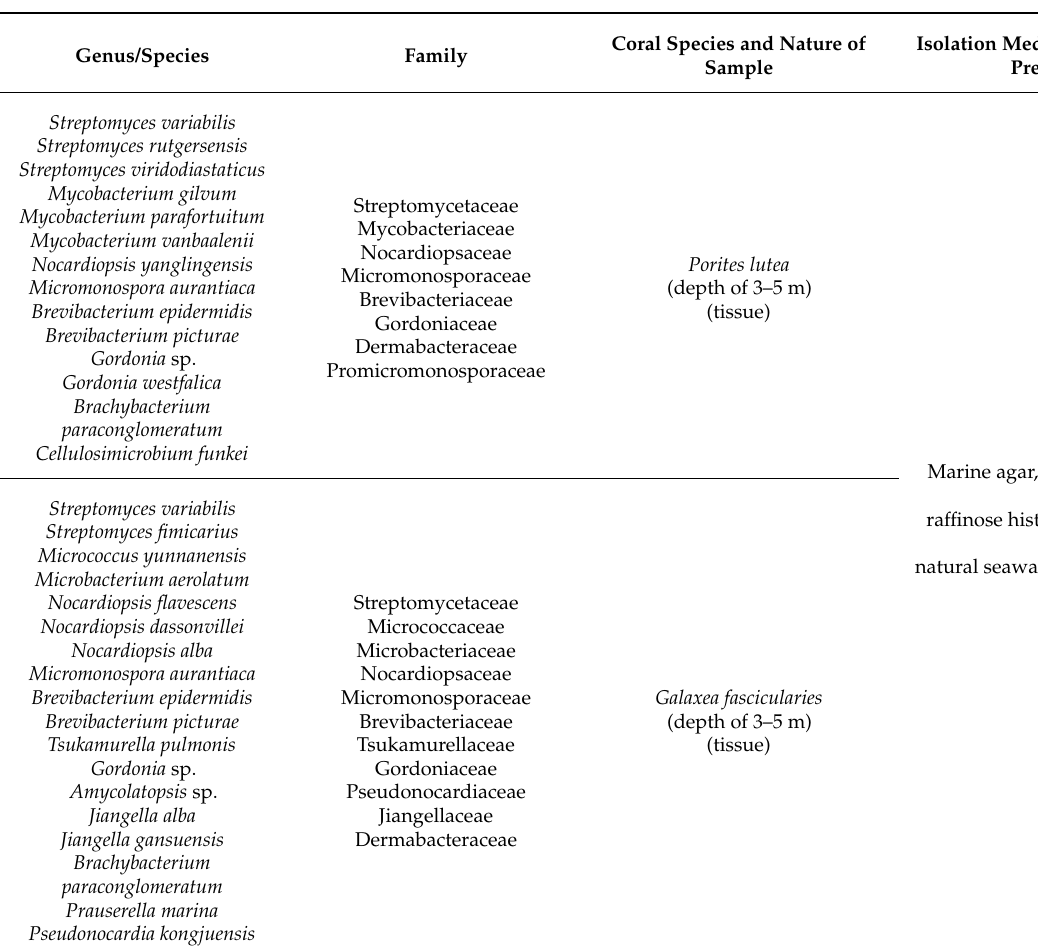
Table 1. Cont. Genus/Species Family